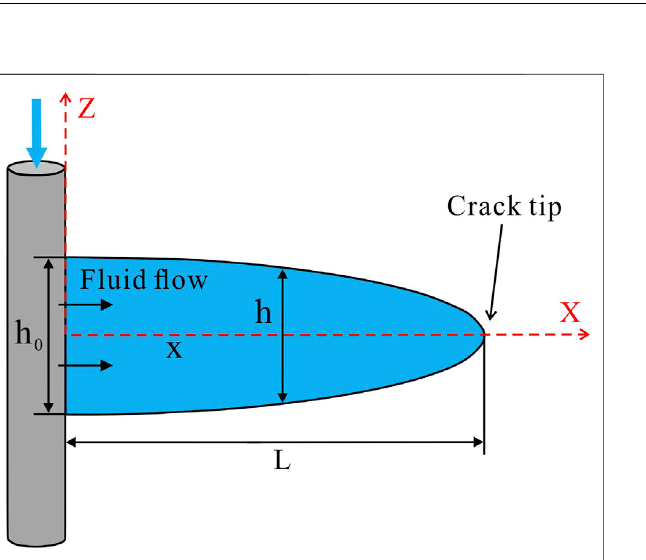
FIGURE 3 | Normal contact stress and the contact gap curve for the cohesive zone